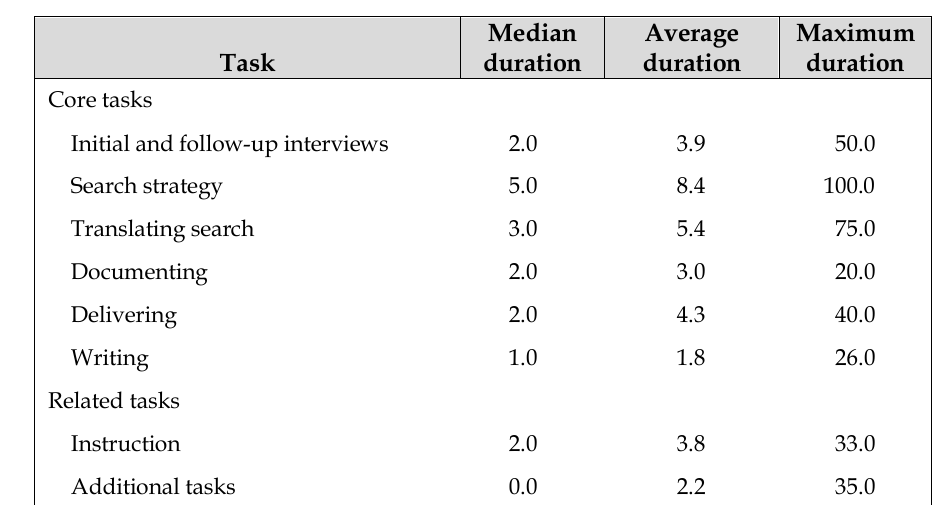
Table 2 SR task time spent in hours